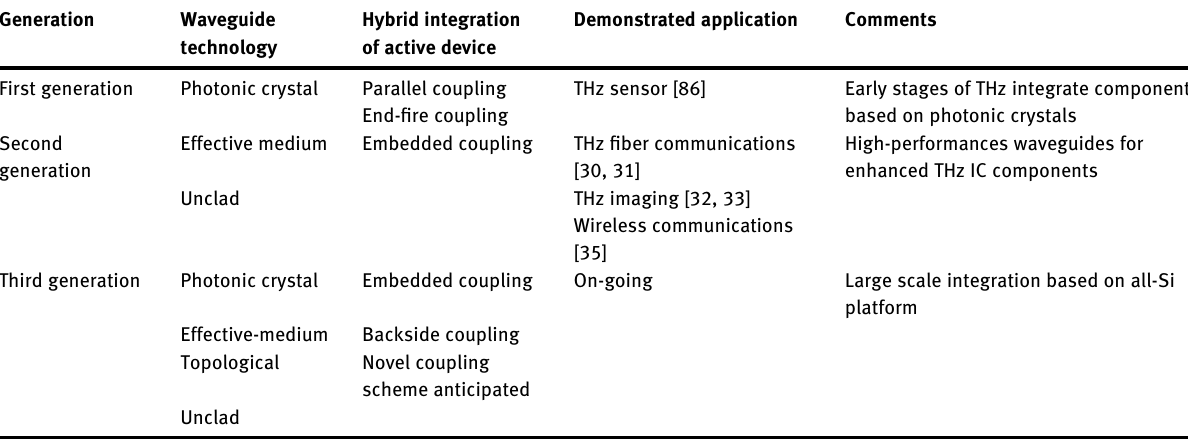
Table  : Summary of THz integrated technologies based on Si